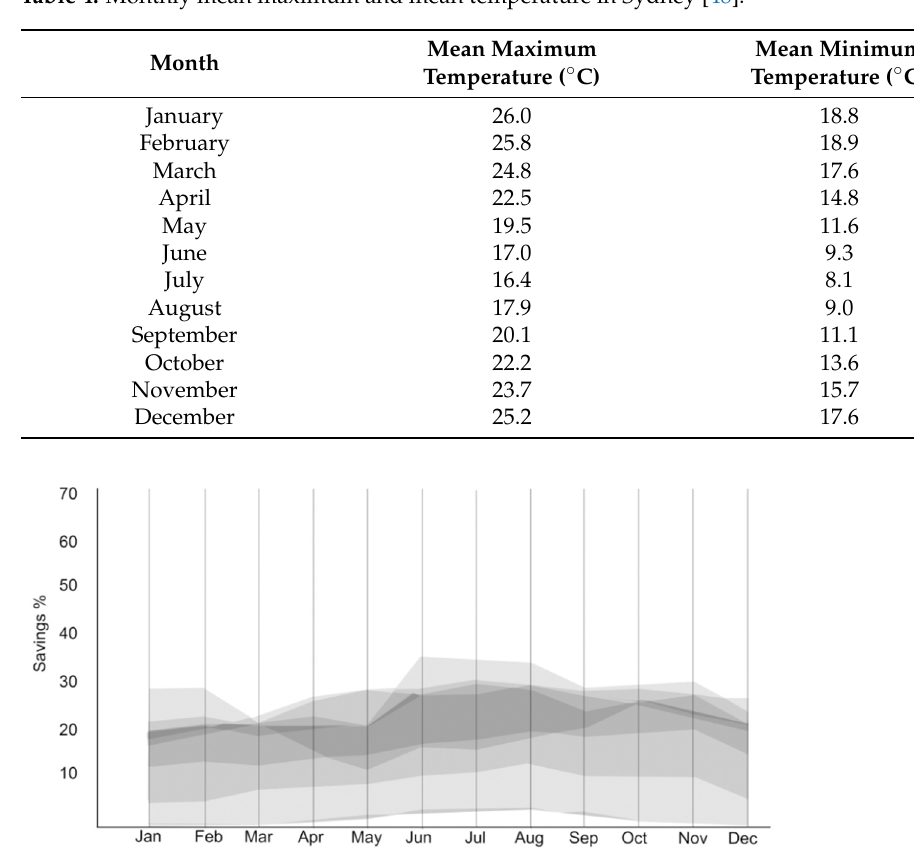
Table 5. Number of hours on a year at different operative temperatures.